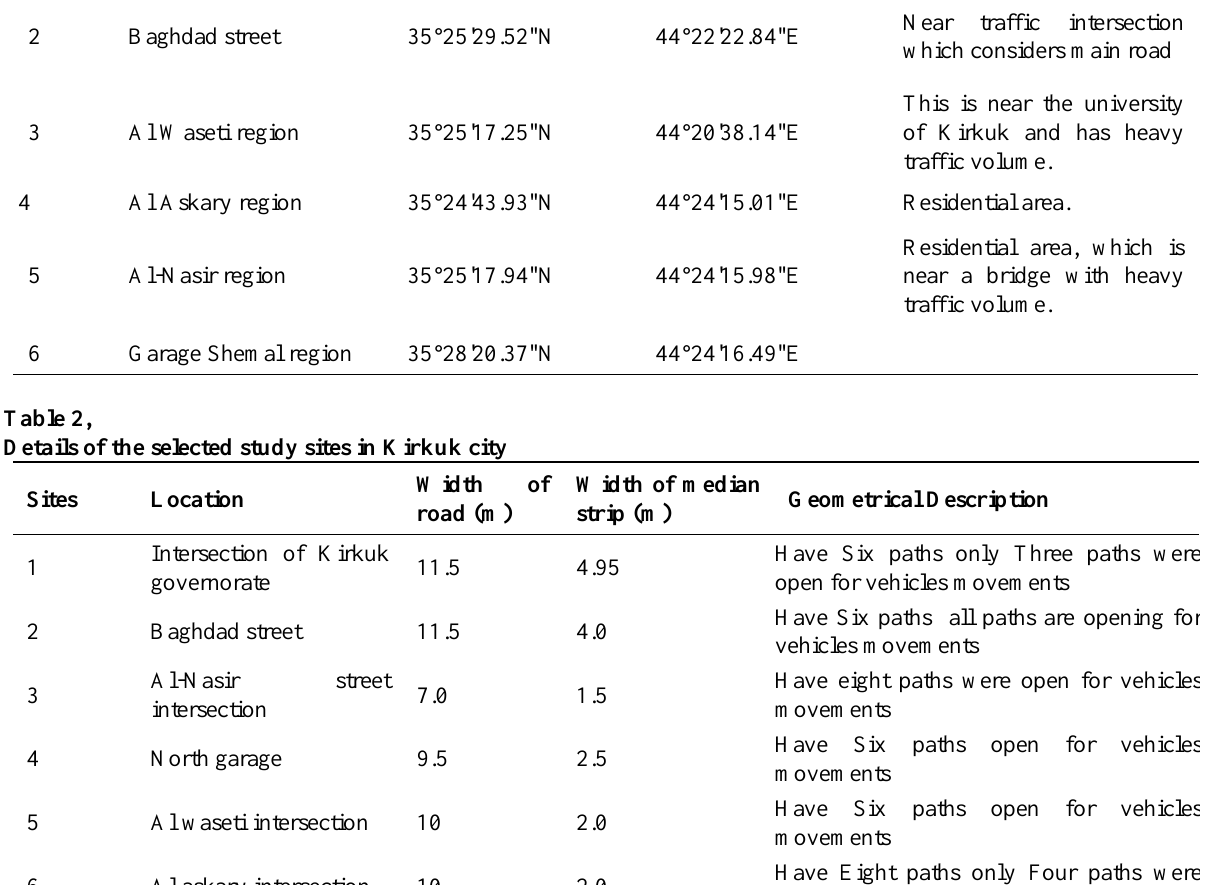
Description of the studied locations in Kirkuk city